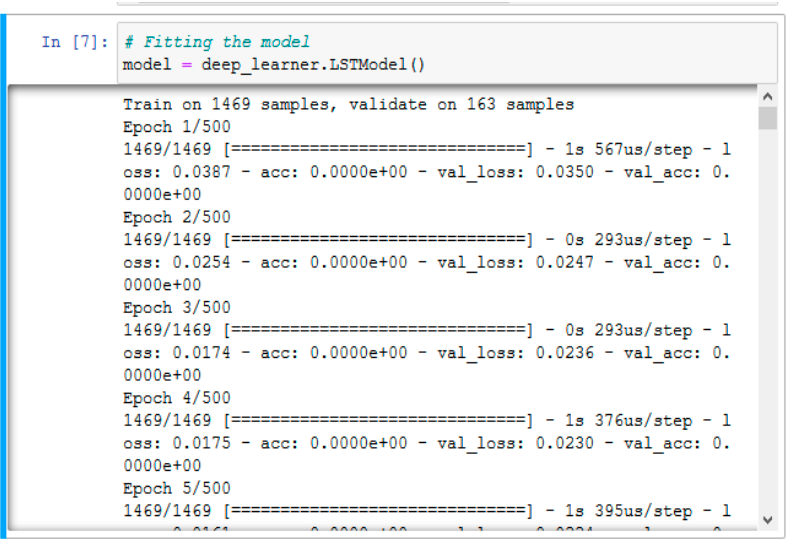
Figure A2. Testing framework of LSTM prediction.